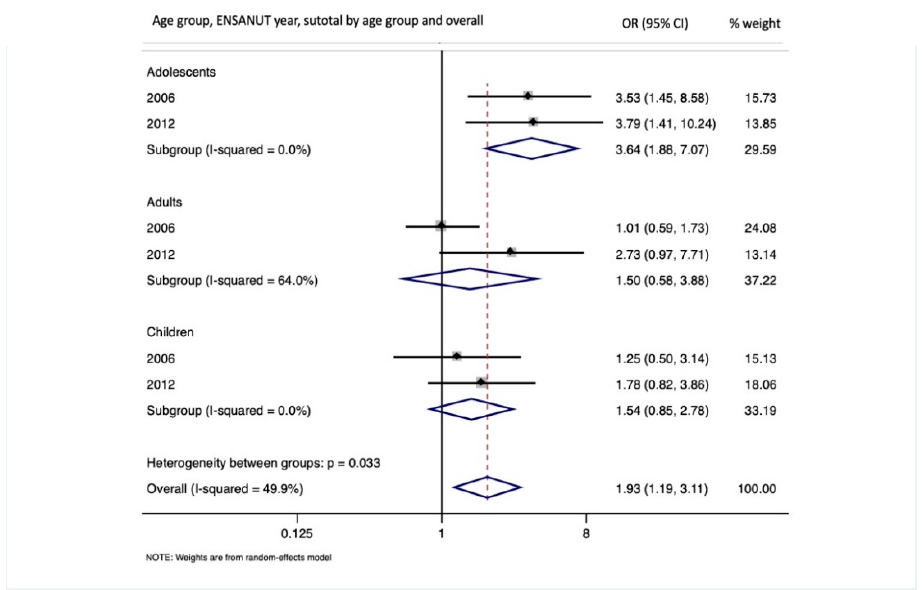
Figure 2. Odds ratios for obesity and PM 2.5 exposure (per 10 µg/m 3 increase) using a meta-analysis approach, by age group and for the overall study.